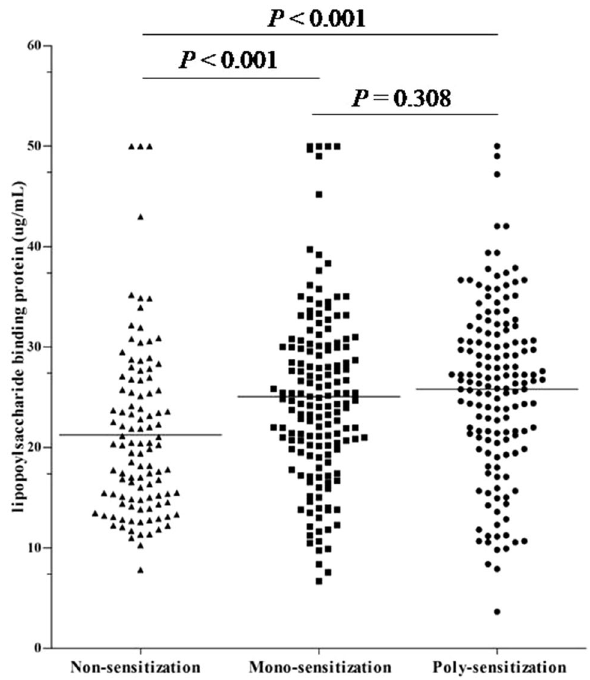
Figure 1. Serum LBP levels of children who were non-sensitized (n = 107), mono-sensitized (n = 160), and poly-sensitized (n =